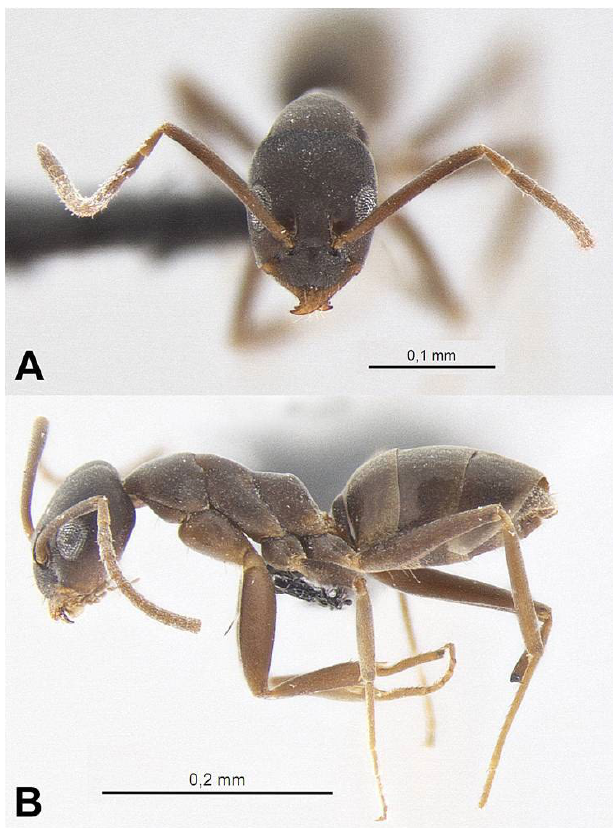
Fig 1 . Gracilidris pombero worker (Aceguá, RS, Brazil). A: Head in frontal view. B: Body in profile.